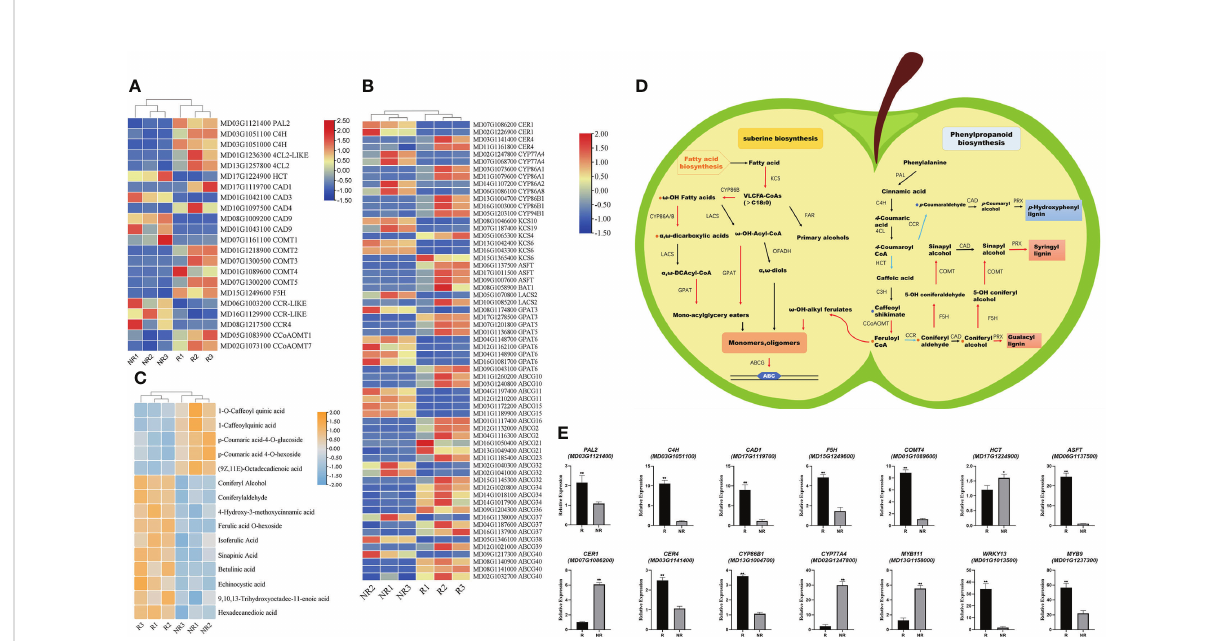
FIGURE 5 Integrated analysis of metabolomic and transcriptomic pro fi ling. (A) DEGs involved in the lignin synthesis pathway. (B) DEGs involved in the suberin and cutin synthesis pathway. (C) Potential DAMs involved in fruit russeting. (D) Proposed model of russeting in apples (Red and blue arrows indicate upregulated and downregulated genes in the pathway, respectively; red and blue circles indicate the increased and reduced metabolites, respectively). (E) qRT-PCR validation of the transcriptome data; signi fi cance was calculated according to Student ’ s t- test: * P < 0.05, ** P <